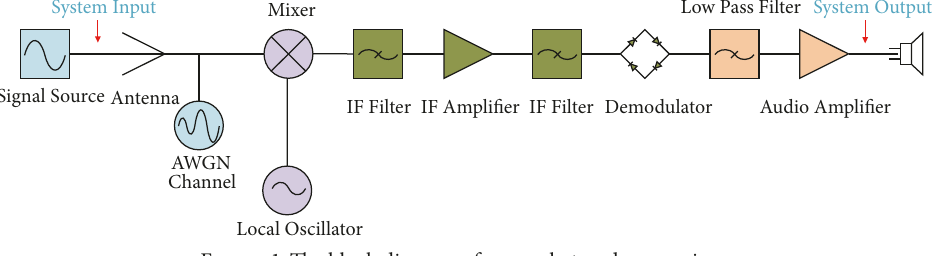
Figure 1: The block diagram of a superheterodyne